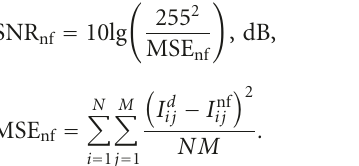
(Figure 1). IPSNR is about 3 dB for σ 2 = 50 and 100 and about 5.5 dB for σ 2 = 400 for the test image Barbara (Figure